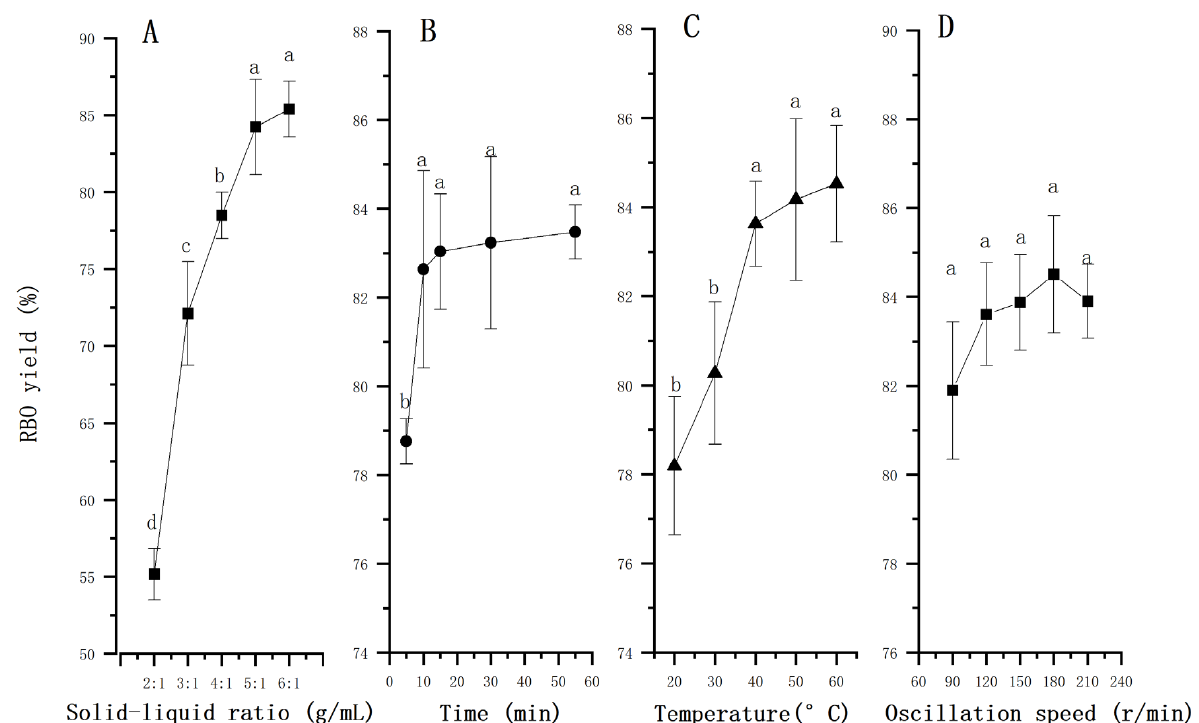
Figure 3. Effects of solid–liquid ratio ( A ), extraction time ( B ), extraction temperature ( C ), and oscillation speed ( D ) on RBO yield. Different lowercase indicate significant differences among groups ( p < 0.05).